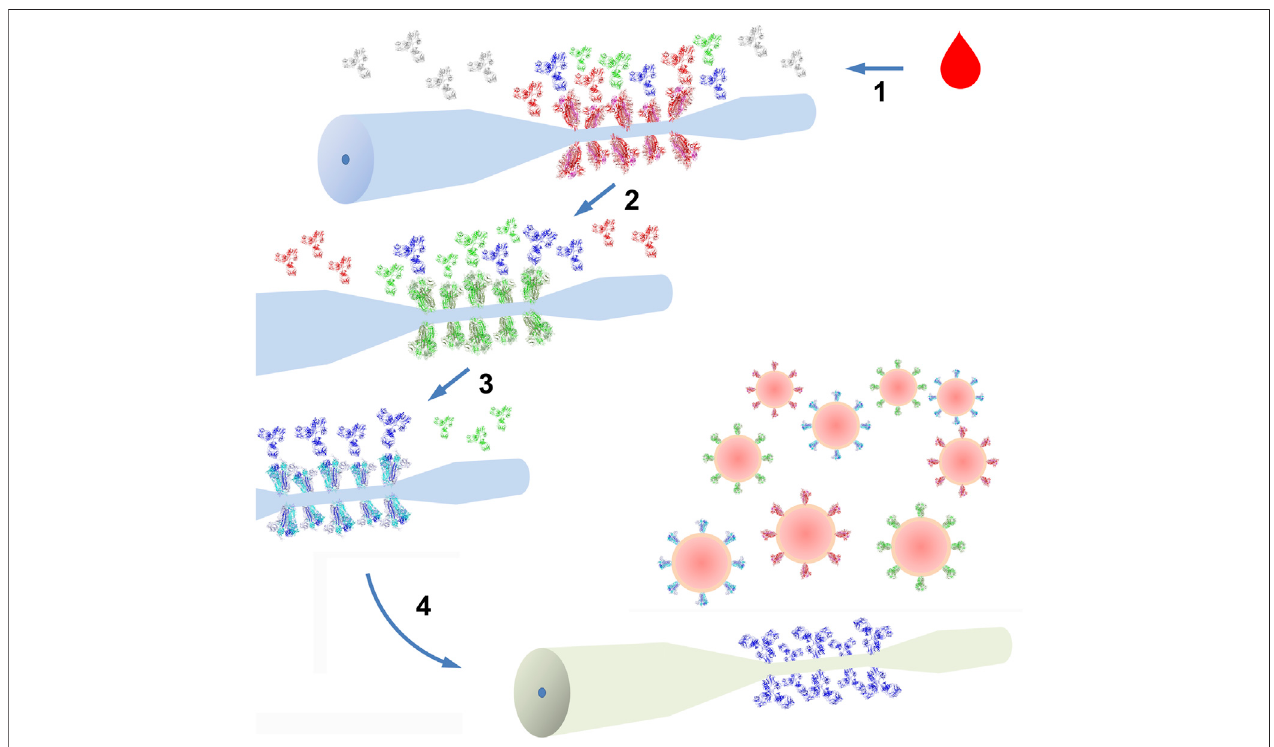
FIGURE 1 | Schematics of HCoV bnAbs discovery and implementation. Blood samples from COVID-19 survivors (1) undergoes testing for SARS-CoV-2 spike antibody (red, green and blue) speci fi city (irrelevant antibodies are represented in grey). Antibody puri fi cation and testing for SARS-CoV spike antibody (green and blue) speci fi cityisthefollowingstep(2).Next, asecondantibodypuri fi cationstepanda fi naltestingforMESR-CoVspike(3)canrevealbrAbs(blue).AftersingleBcellisolation fromsurvivors ’ blood,antibodyproductionandtestingforbroadneutralization,brAbsandbnAbs(4)canbeusedtodeviseoptical fi berbiosensorsfortheuniversal detection of HCoVs (red, green and blue spiked viruses). Optical fi bers represented are eTFBG, as an example of biosensor technology. Protein 3D structures were generated using PyMOL and represented in ribbon: SARS-CoV-2 spike trimers (red) are from PDB entry 6VYB, SARS-CoV (green) from PDB entry 5XLR, MERS-CoV (blue) from PDB entry 5 × 5F and antibodies from PDB entry 1IGY